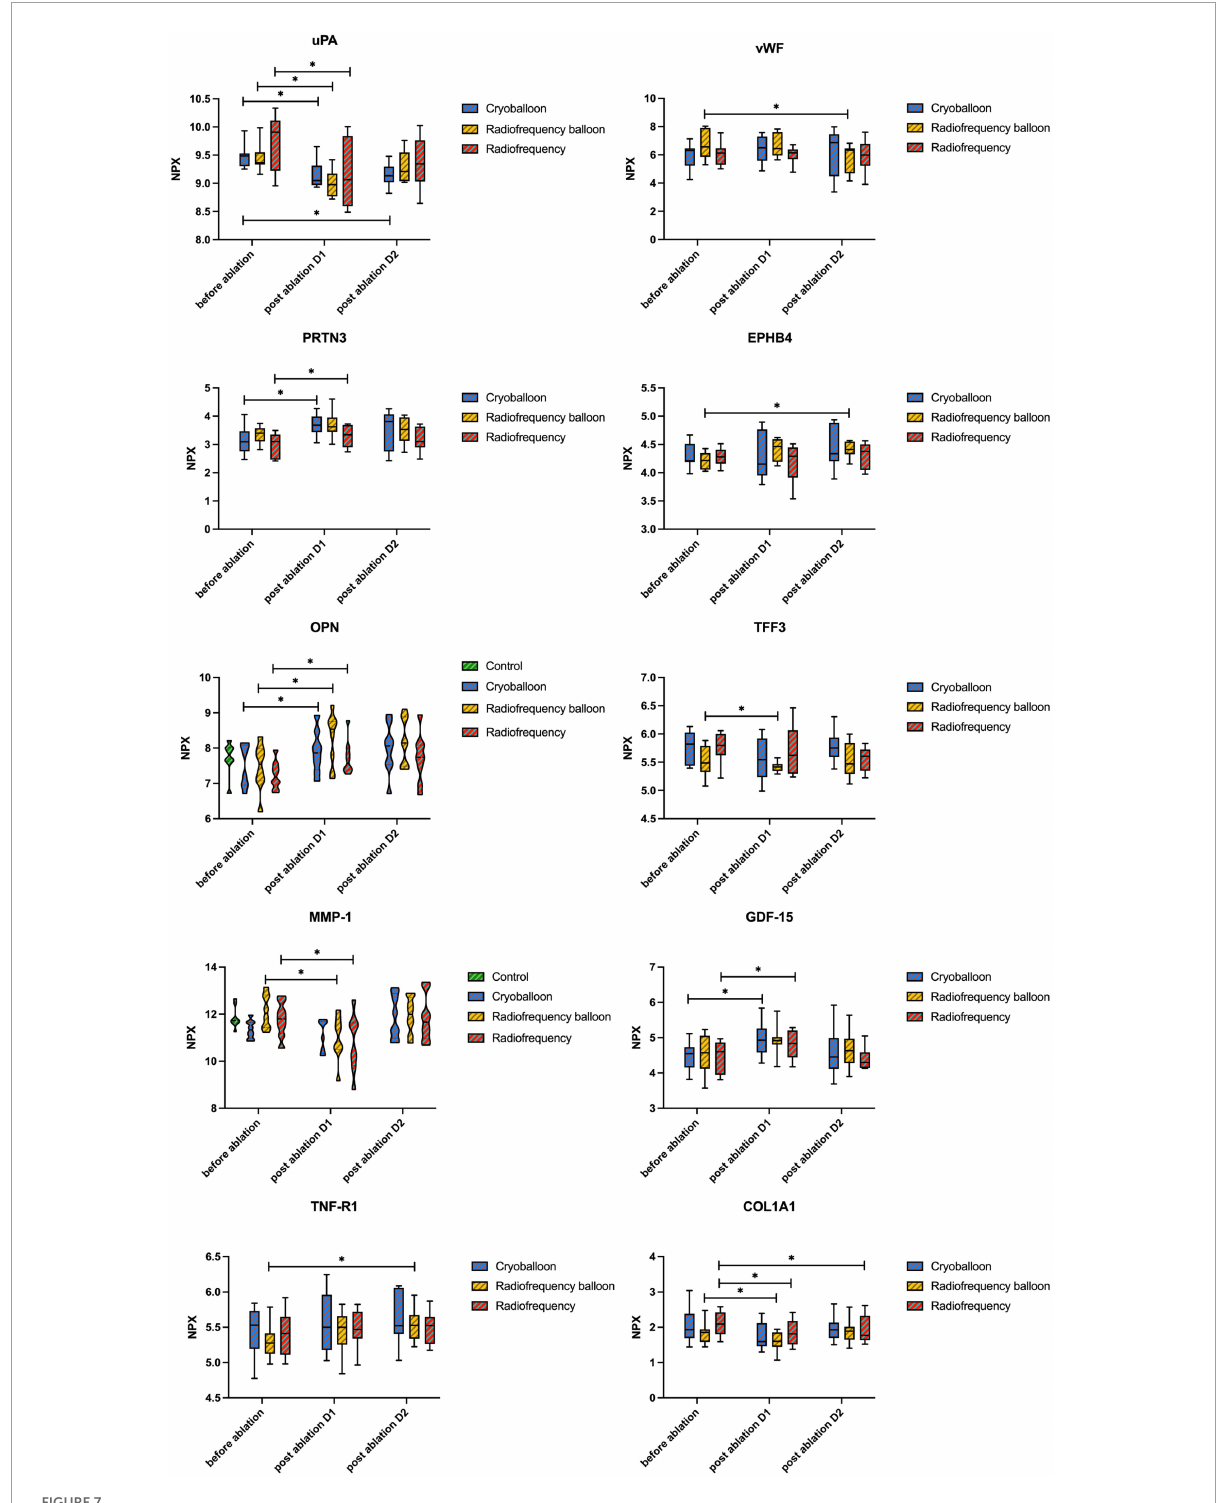
FIGURE7 Levels of proteins associated with hemorrhage and coagulation activity. No differences were seen between the groups at any time point. Differences before and after ablation were assessed with the Wilcoxon signed-rank test. P -values are given for comparison within the group between different time points. uPA, urokinase-type plasminogen activator; TFF3, trefoil factor 3; GDF-15, growth/differentiation factor 15; PRTN3, myeloblastin; COL1A1, collagen alpha-1(I) chain; TNF-R1, tumor necrosis factor receptor 1; EPHB4, ephrin type-B receptor 4; vWF, von Willebrand factor; NPX, normalized protein expression; ∗ P <0.05. Note that the levels of OPN and MMP-1 are shown in Figure 5